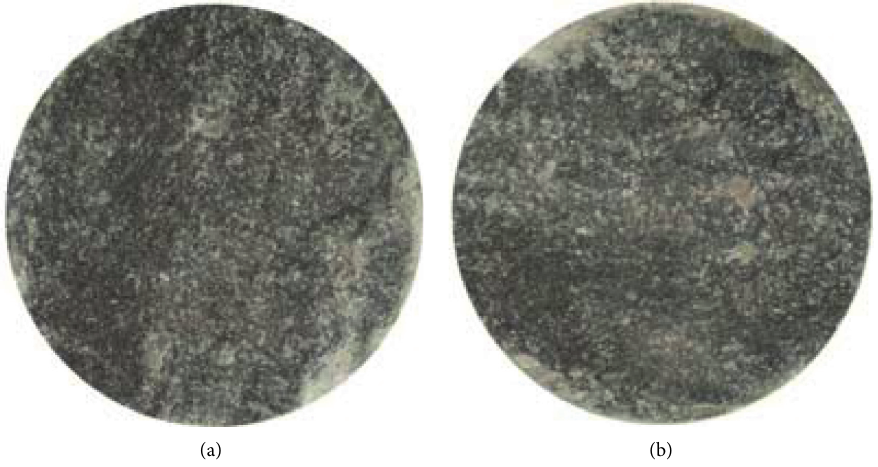
Figure 3: The morphology of rock fractures (take TJ-1 as an example). (a) Upper fracture surface. (b) Lower fracture